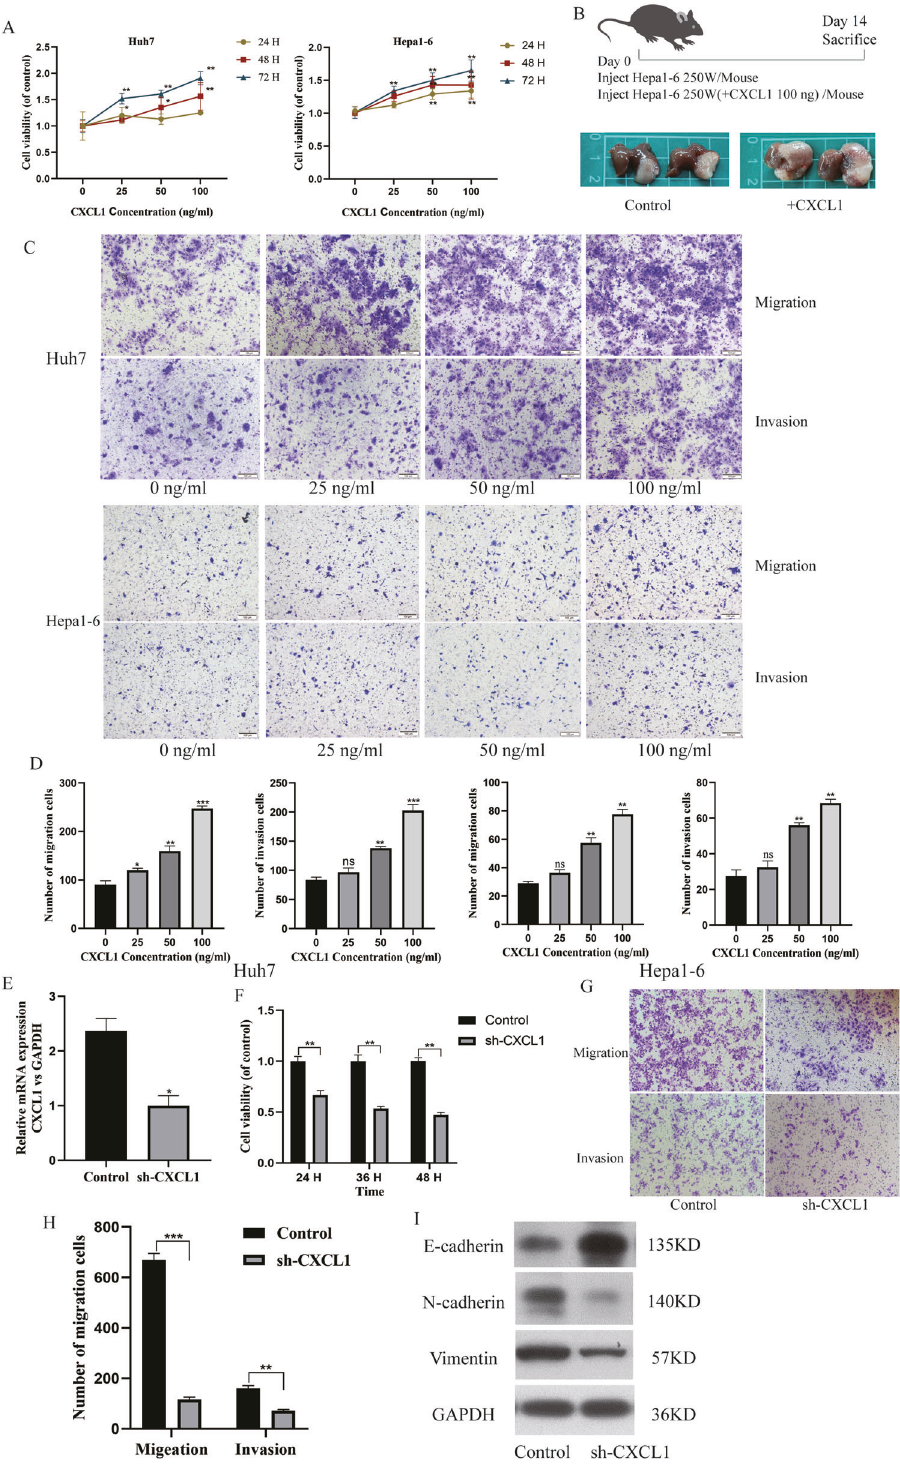
Fig. 2 Potential role of CXCL1 in HCC progression. A Different concentrations of CXCL1 recombinant protein (0 ng, 25 ng, 50 ng, 100 ng/ml) promoted cell proliferation in Huh7 and Hepa1 – 6 cells, as demonstrated by MTT assay at different times (24 h, 48 h, 72 h). Data are expressed as the mean ± SEM. * P < 0.05, ** P < 0.01 ( n = 6/group). B Schematic representation of injected cells and photograph of primary tumours from different groups ( n = 5/group). C , D Photographs and quanti fi cation of Transwell assays results indicated that the addition of recombinant CXCL1 protein increased the metastatic capability of HCC cells. E qRT-PCR analysis was conducted to detect the CXCL1 levels in Huh7 cells that were stably transfected with shRNA vectors or a control vector. Data are expressed as the mean ± SEM. * P < 0.05 ( n = 3/group). F MTT assay revealed that the proliferation of sh-CXCL1-Huh7 cells was decreased. Data are expressed as the mean ± SEM. ** P < 0.01 ( n = 6/group). G , H Photograph and quanti fi cation of sh-CXCL1-Huh7 and control-Huh7 cells in the Transwell assay to detect metastasis capability *** P < 0.001. I Western blot analysis showed that sh-CXCL1 inhibited EMT signalling.